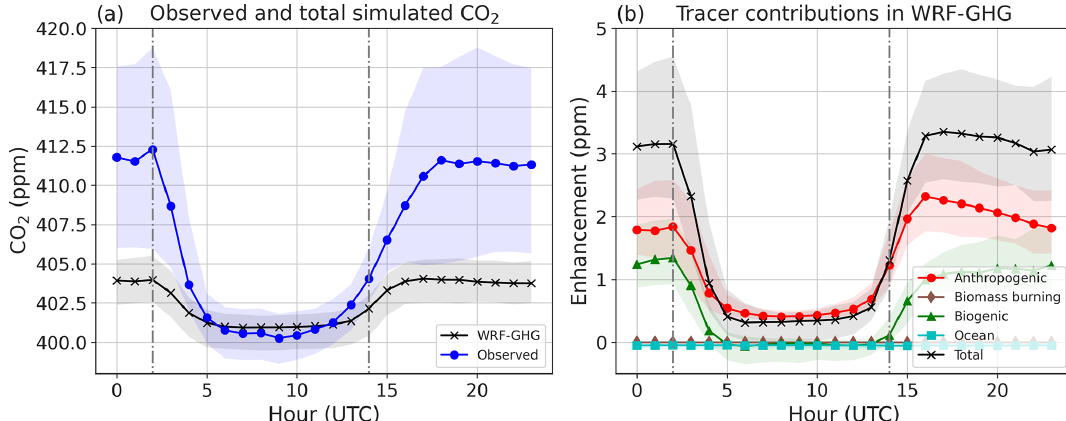
Figure 7. Diurnal cycle of (a) in situ CO 2 at SDe (b) and model tracer contributions. The black line in panel (a) represents the median hourly concentrations of WRF-GHG, while the blue line represents the observed values. The shaded areas cover the interquartile ranges. The gray dotted vertical lines at 02:00 and 14:00UTC indicate the approximate times of sunrise and sunset. The colored lines in panel (b) represent the different tracer deviations from the background concentration in WRF-GHG, including anthropogenic (red), biogenic (green), ocean (cyan), and biomass burning (brown) tracers. The black line is the sum of all tracers, except the background.